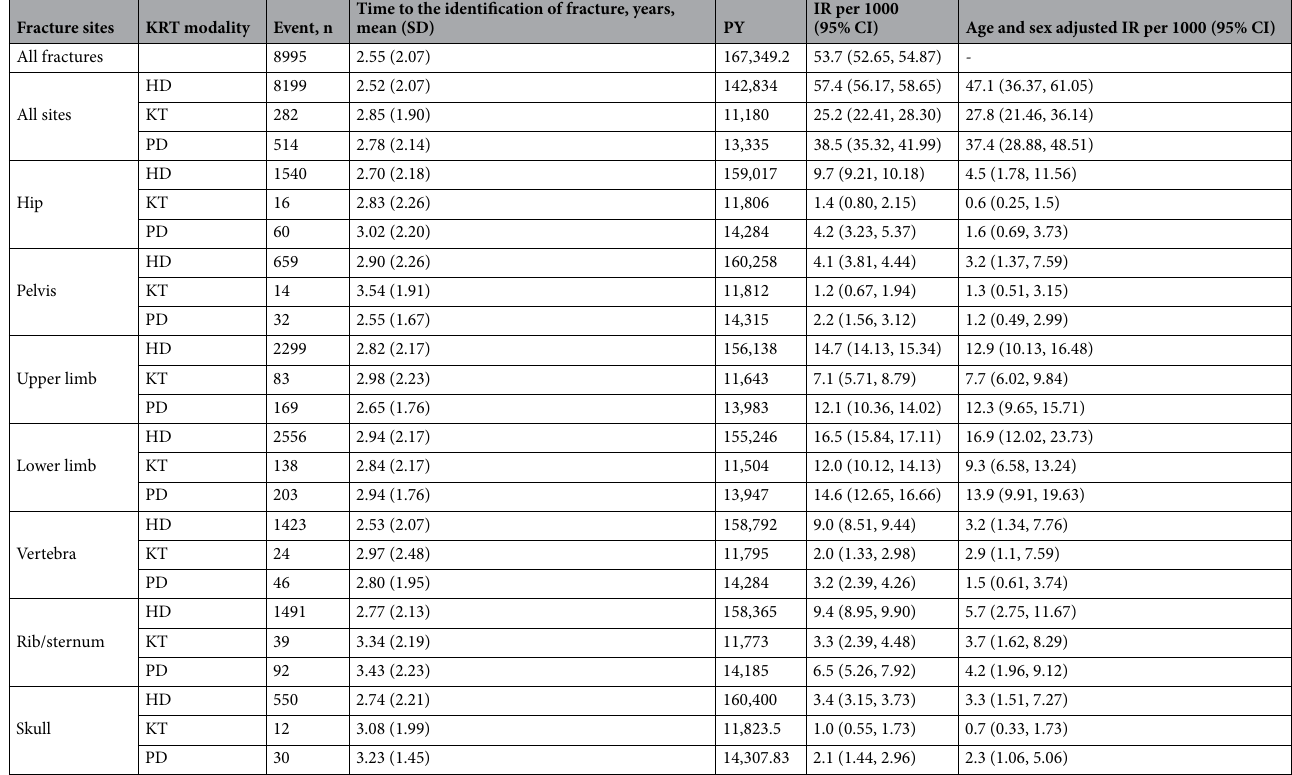
Table 3. Time to first fracture identification and fracture site among end-stage kidney disease patients stratified by KRT. CI confidence interval, HD hemodialysis, IR incidence rate, KRT kidney replacement therapy, KT kidney transplant, PD peritoneal dialysis, PY person-years, SD standard